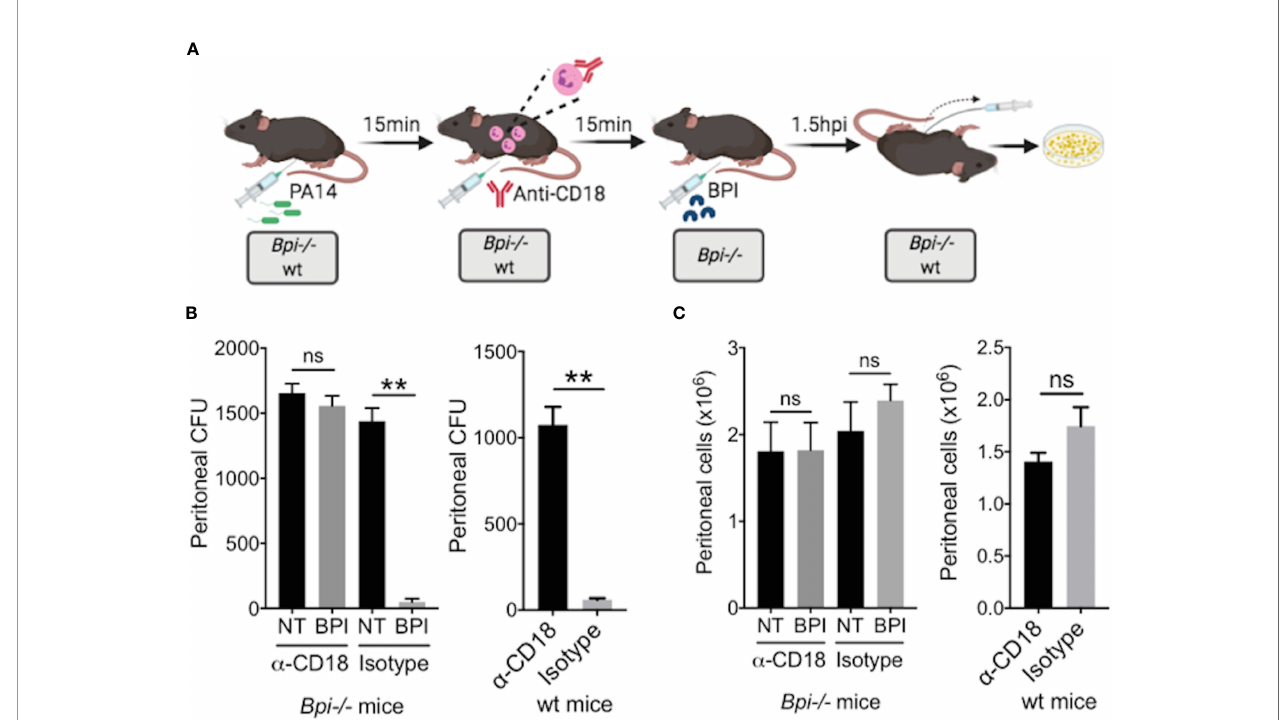
FIGURE 5 | BPI mediates P. aeruginosa clearance in vivo preeminently by phagocytosis, dependent on CD18. (A) Mice (wt or Bpi-/- ) were infected with 3x10 6 CFU P. aeruginosa PA14 15mins prior to anti-CD18 antibody administration (50 m g), via intraperitoneal (i.p.) route. In Bpi-/- mice, BPI (10 m g) was then administered